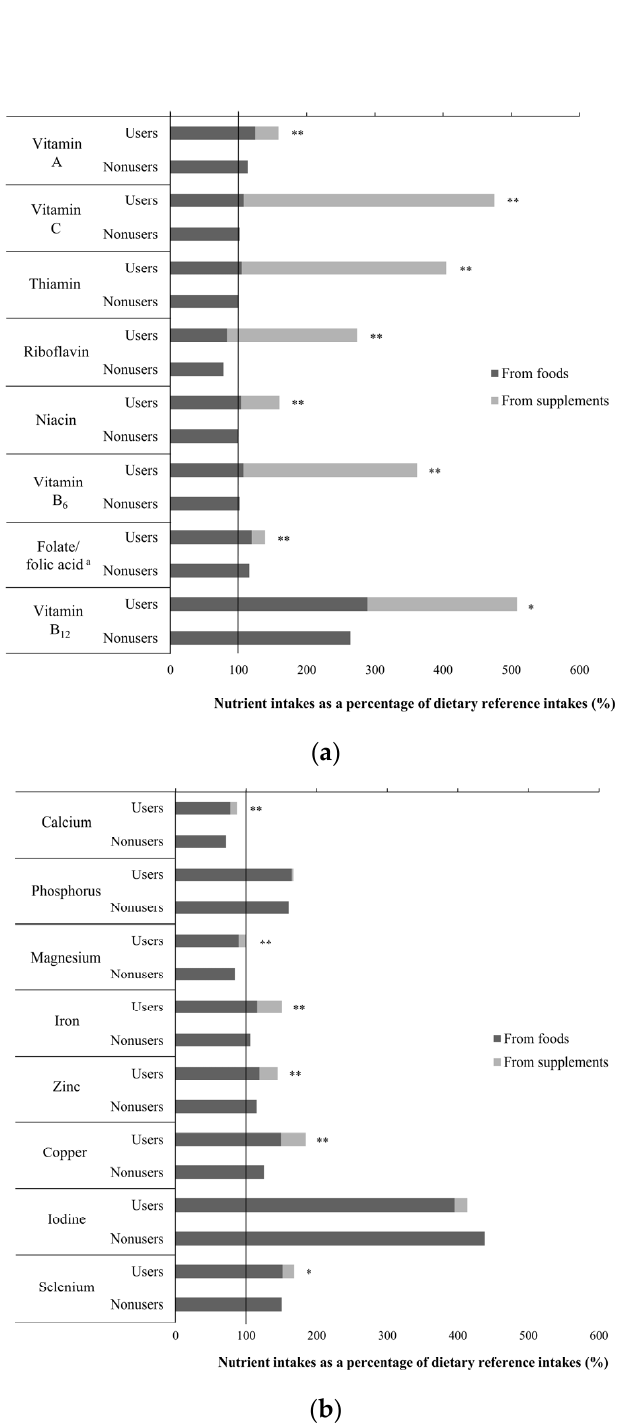
Figure 1. ( a ) Vitamin intakes as a percentage of dietary reference intakes ( n = 586). The solid vertical line indicates the Korean dietary reference intakes. The black bar indicates intake levels from foods only. The gray bar indicates the intakes from vitamin and mineral supplements (VMS). p values are derived from the generalized linear regression analysis for the difference in nutrient intakes when compared to recommended nutrient intakes between VMS users and non-users. * p < 0.01, ** p < 0.001. a The black bar indicates folate intake levels from food sources and the gray bar indicates folic acid intake levels from supplements. ( b ) Mineral intakes as a percentage of dietary reference intakes ( n = 586). The solid vertical line indicates the Korean dietary reference intakes. The black bar indicates intake levels from foods only. The gray bar indicates the intakes from VMS. p values are derived from the generalized linear regression analysis for the difference in nutrient intakes when compared to recommended nutrient intakes between VMS users and non-users. * p < 0.01, ** p < 0.001.